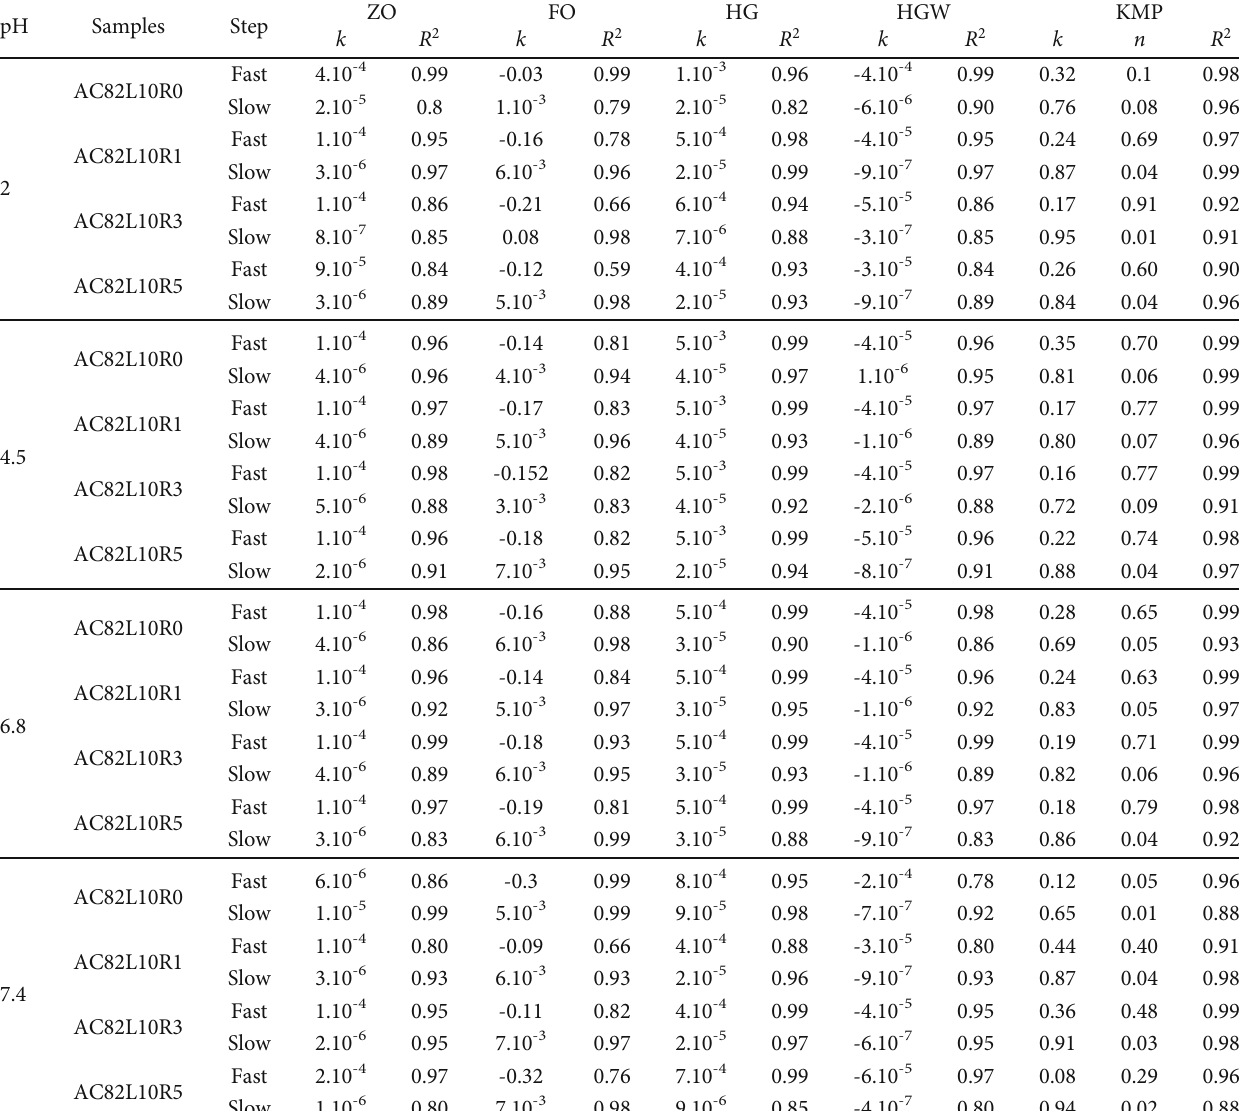
Table 7: Regression coe ffi cient ( R 2 ) and release constant ( k ) obtained from kinetic equations re fl ecting LOV release from the AC82L10R x fi lms in di ff erent pH